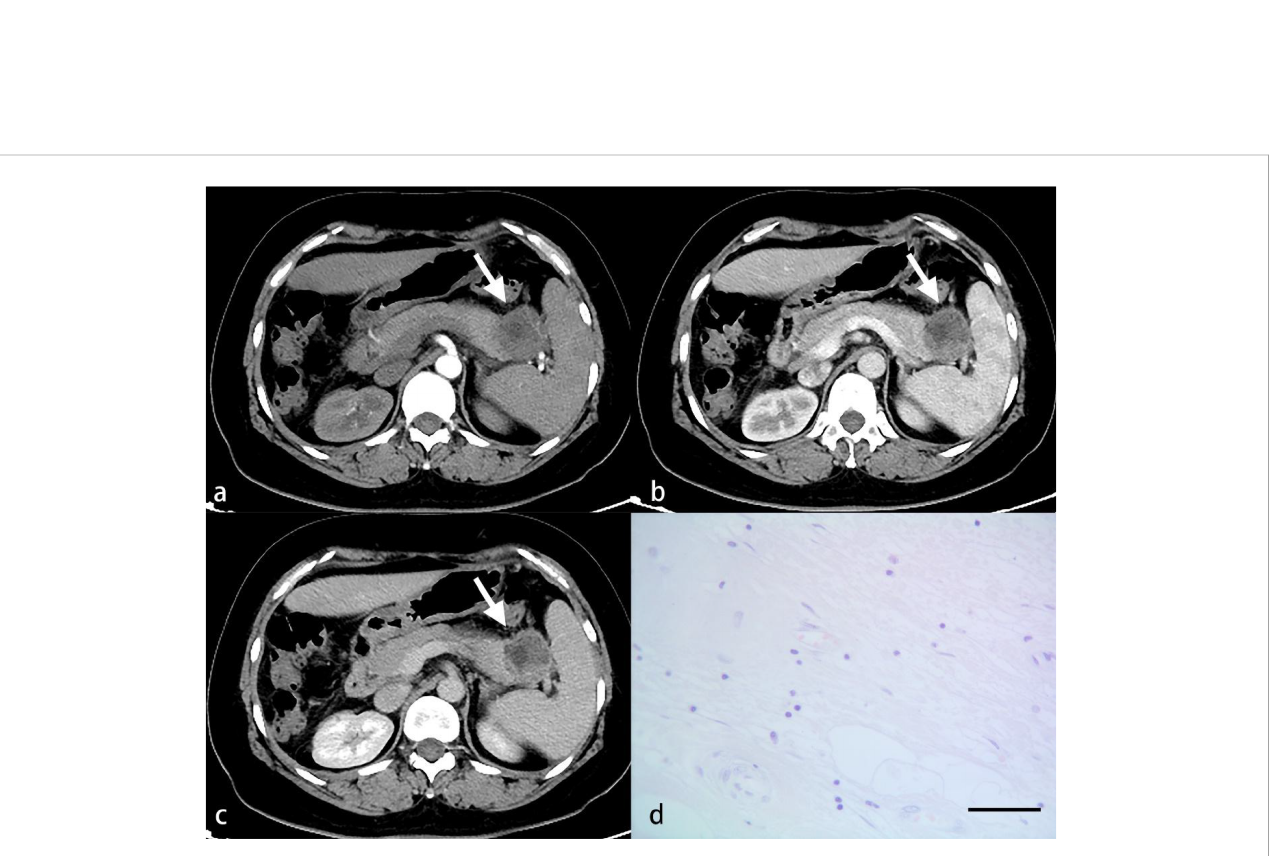
FIGURE 4 A 56-year-old woman with PDAC. Arterial (A) , venous (B) and delayed (C) phase CT images show a well-de fi ned mass in the tail of the pancreas (arrow). A small number of in fl ammatory cells are observed under light microscopy (D) . (HE, scale bar=50 m